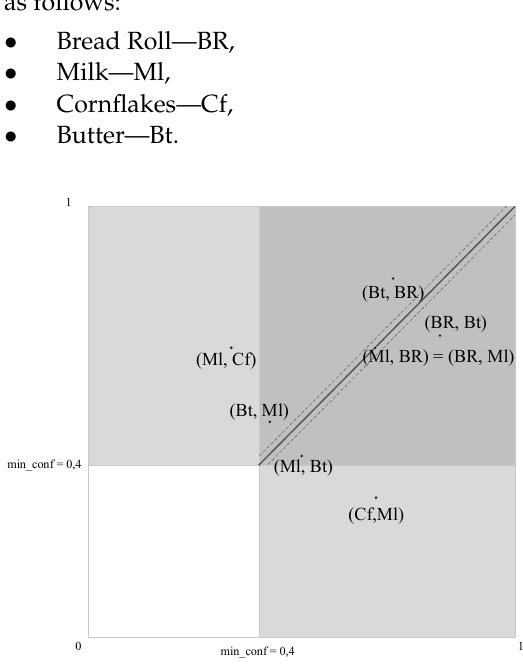
Figure 2. B -complementarity of goods based on Table 1.